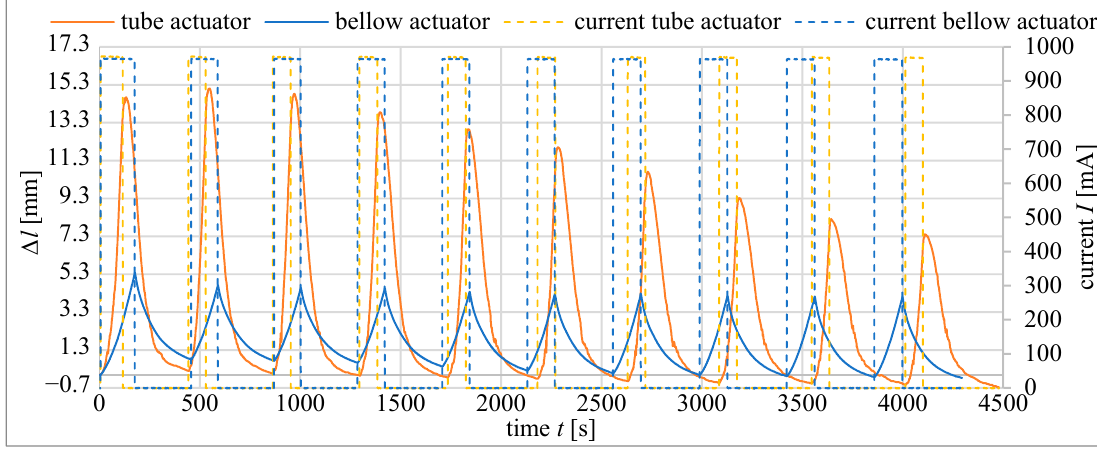
Figure 20. Cyclic work of the tube actuator ( D = 20.5 mm, l 0 = 40.0 mm) and the bellow actuator S.